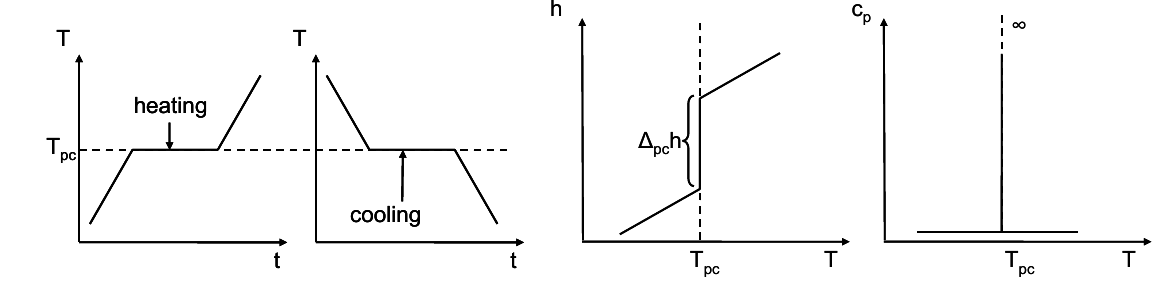
Figure 1. Ideal phase change: heating and cooling T(t), as well as h(T) and c p (T).